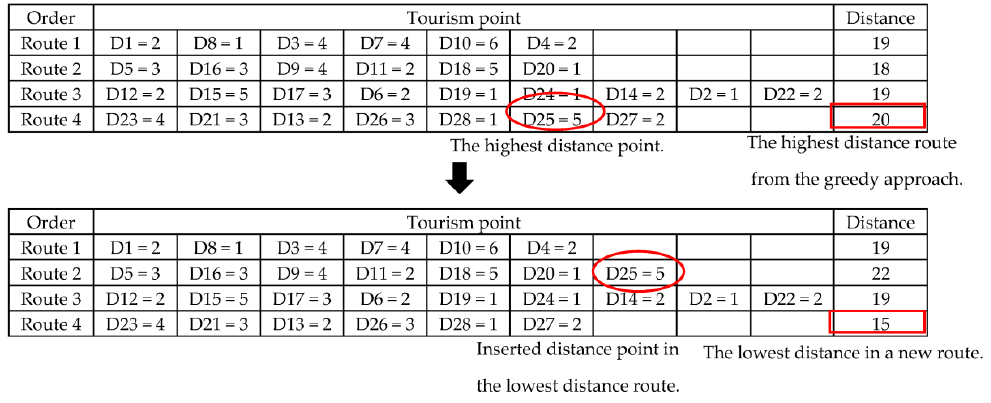
Figure 7. Example of Regret-H insertion.